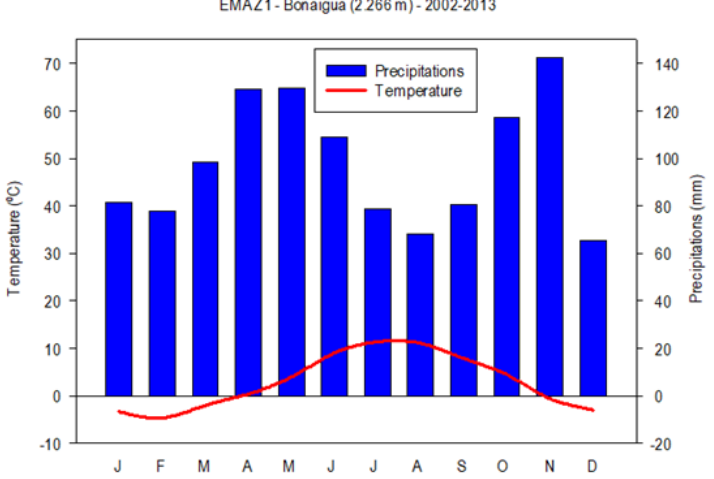
Figure 3. Diagram showing temperature and precipitation based on meteorological data from an automatic ground station (Bonaigua, XEMA, 2266 m a. s. l.) very close to the Clots de Rialba peat bog. Source: Catalan Meteorological Service (SMC, meteo.cat) .